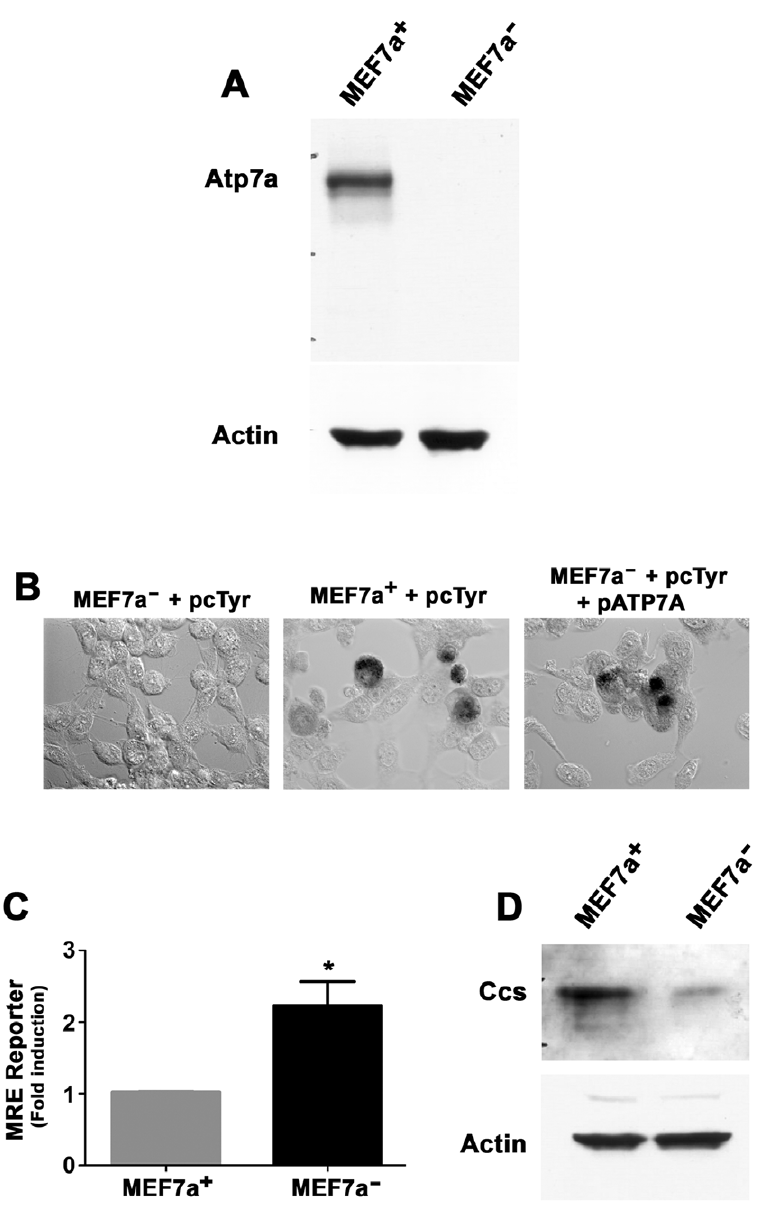
Figure 5. Characterization of MEF7a + and MEF7a 2 cells. A) Immunoblot analysis of Atp7a protein in MEF7a + and MEF7a 2 cells. Blots were probed with anti-Atp7a antibody (1:5000) followed by HRP-conjugated anti-rabbit antibody (1:5000). B) Defective copper delivery to